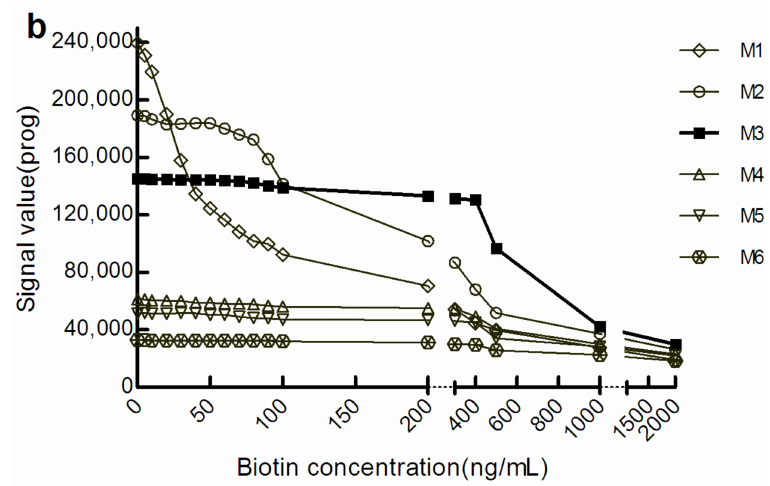
Figure 1. The optical signal changes with different concentrations of biotin samples. ( a ) light signal intensity in the sandwich assay; ( b ) light signal intensity in the competitive assay. The concentrations of M1 to M6 were 0.72, 1.44, 2.16, 2.88, 3.60, and 7.20 mg/mL, respectively. β -hCG: β -human chorionic gonadotropin; Prog: